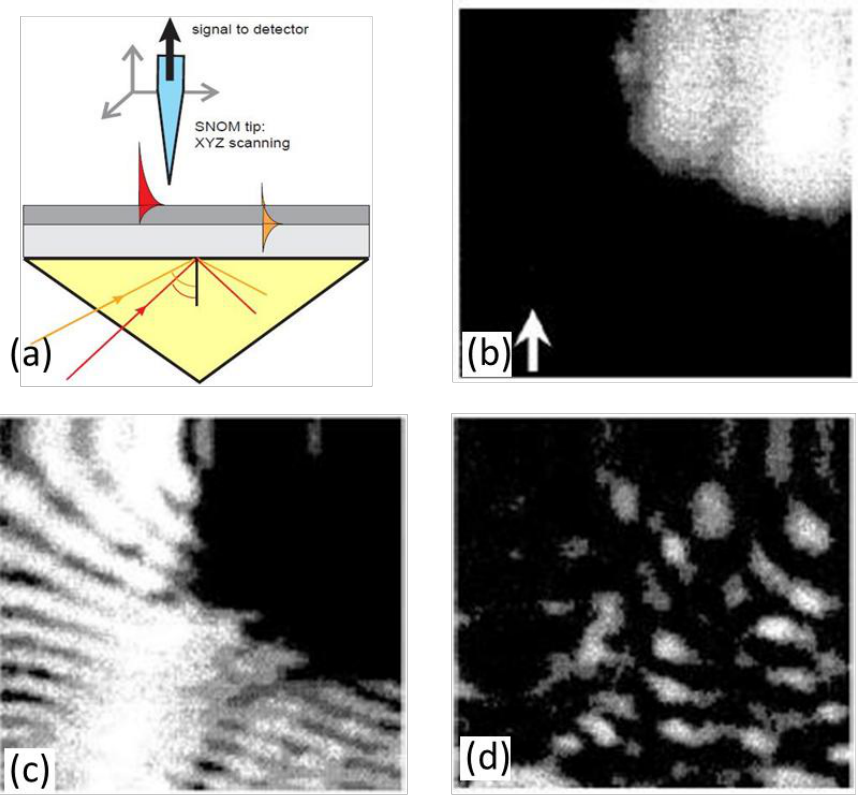
Figure 14. ( a ) Schematic of a SNOM experimental set-up for studying surface plasmon polaritons (SPP) [97]. Topography ( b ), near-field, ( c ) and far-field ( d ) intensity distributions over the smooth gold surface [98]. Reprinted with permission from Ref. [97,98].